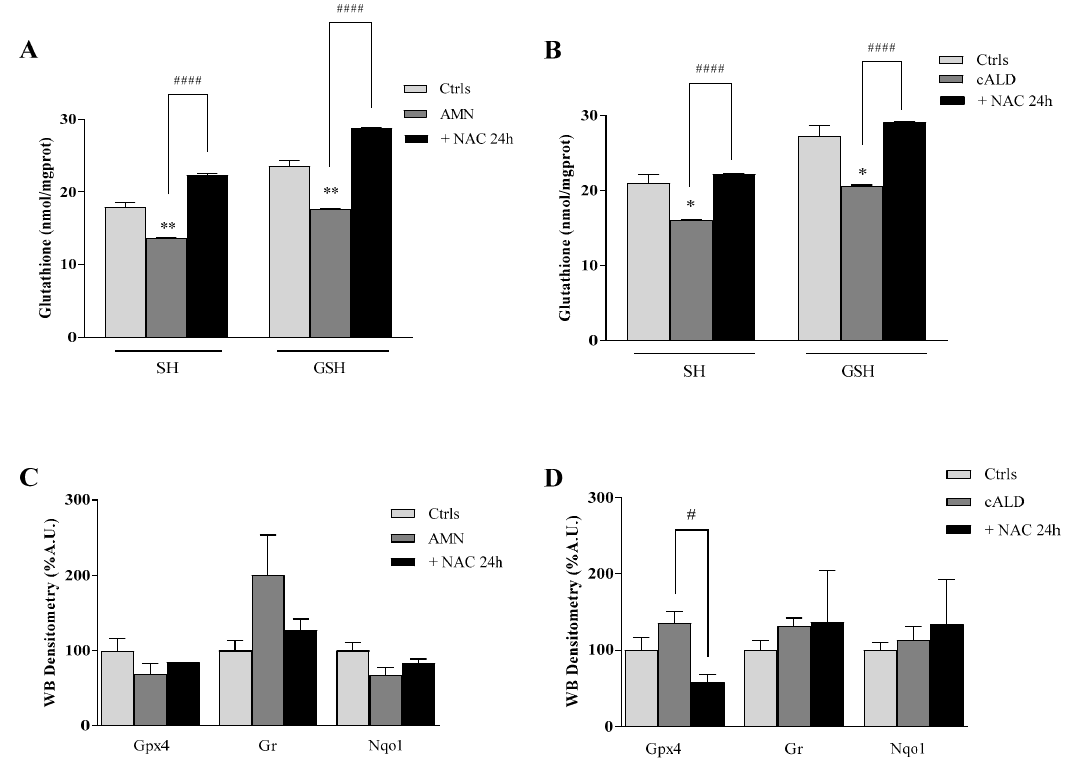
Figure 4. Antioxidant enzymes expression in fibroblasts of patient with X-ALD after 24 h treatment with NAC (100 µ M). ( A , B ) Thiols and Glutathione (GSH) content. ( C , D ) Densitometric analysis of Gpx4, Gr, and Nqo1 protein levels. Experiments were performed in triplicates and values expressed as mean ± SD. * p < 0.05, ** p < 0.01, compared to controls (by Student’s two-tailed t -test). # p < 0.05, #### p < 0.001, respect to untreated patient’s